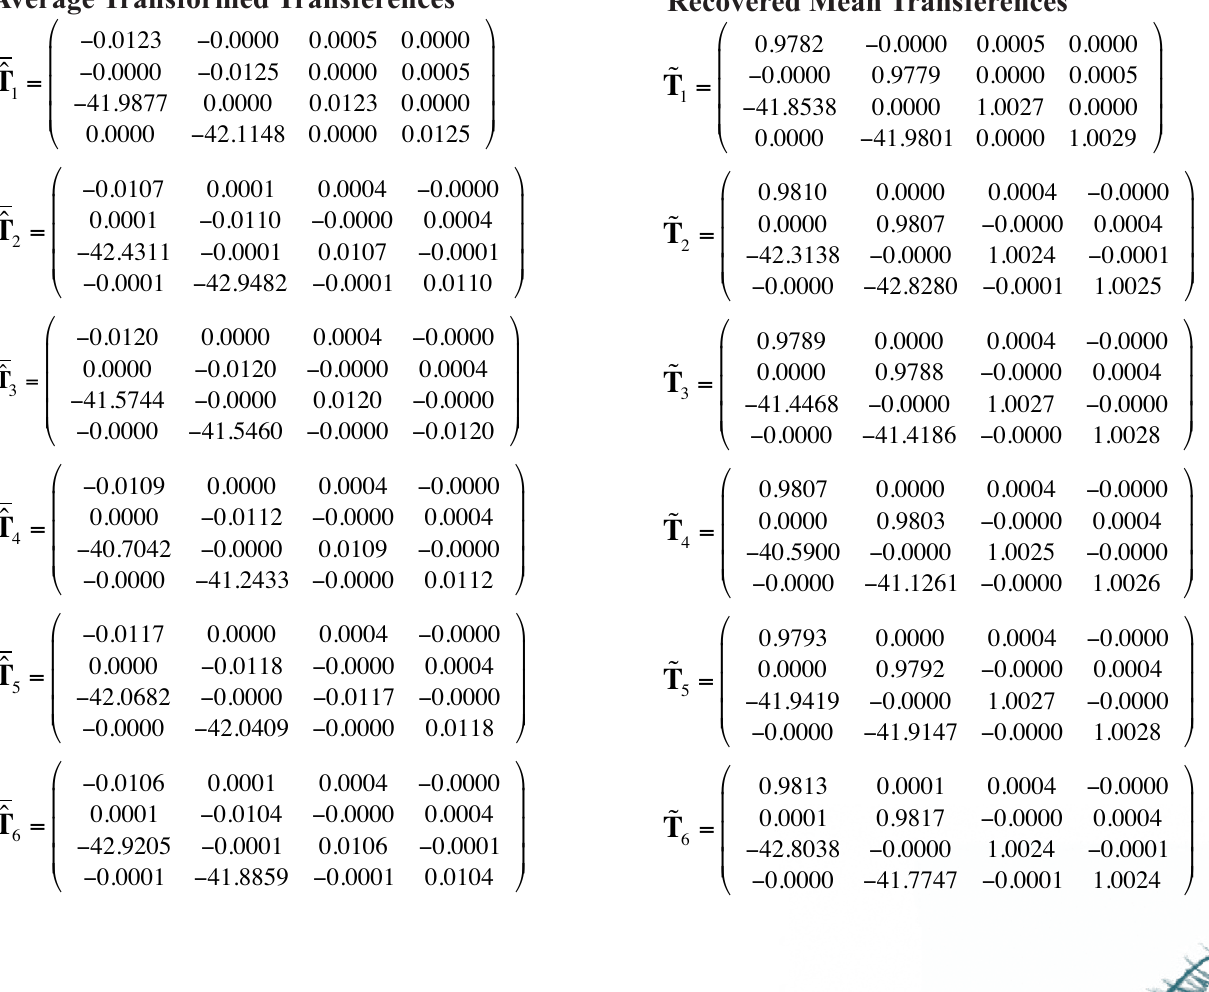
Table 1. Averages of transformed ( ˆ T ) in Hamiltonian space and recovered (  T ) mean transferences for the corneas of the 10 sub- jects are indicated. Subscripts from 1 to 10 are used to indicate the ten different subjects. Units have been omitted to save space but for each transference disjugacy B (the top-right four numbers) has the unit metres while the sub-matrix C (bottom-left four entries) is in dioptres. All other entries are unitless. The mean transformed transferences are determined in Hamiltonian space and the mean transferences are recovered using the matrix